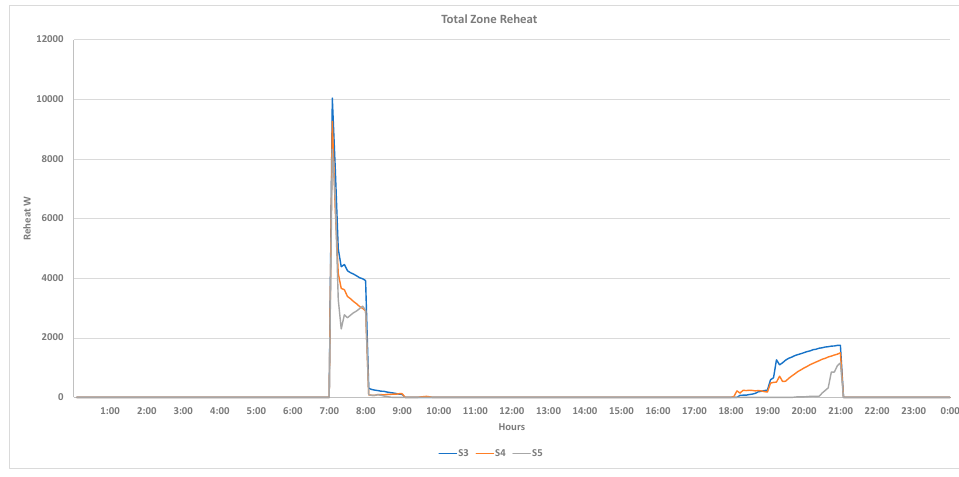
Figure 4. Supply air temperature setpoints for strategies S3, S4, and S5.